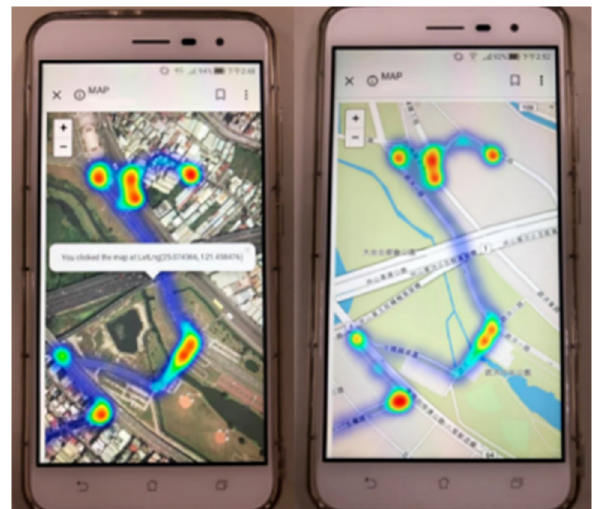
Figure 5. Heat distribution in Leaflet.